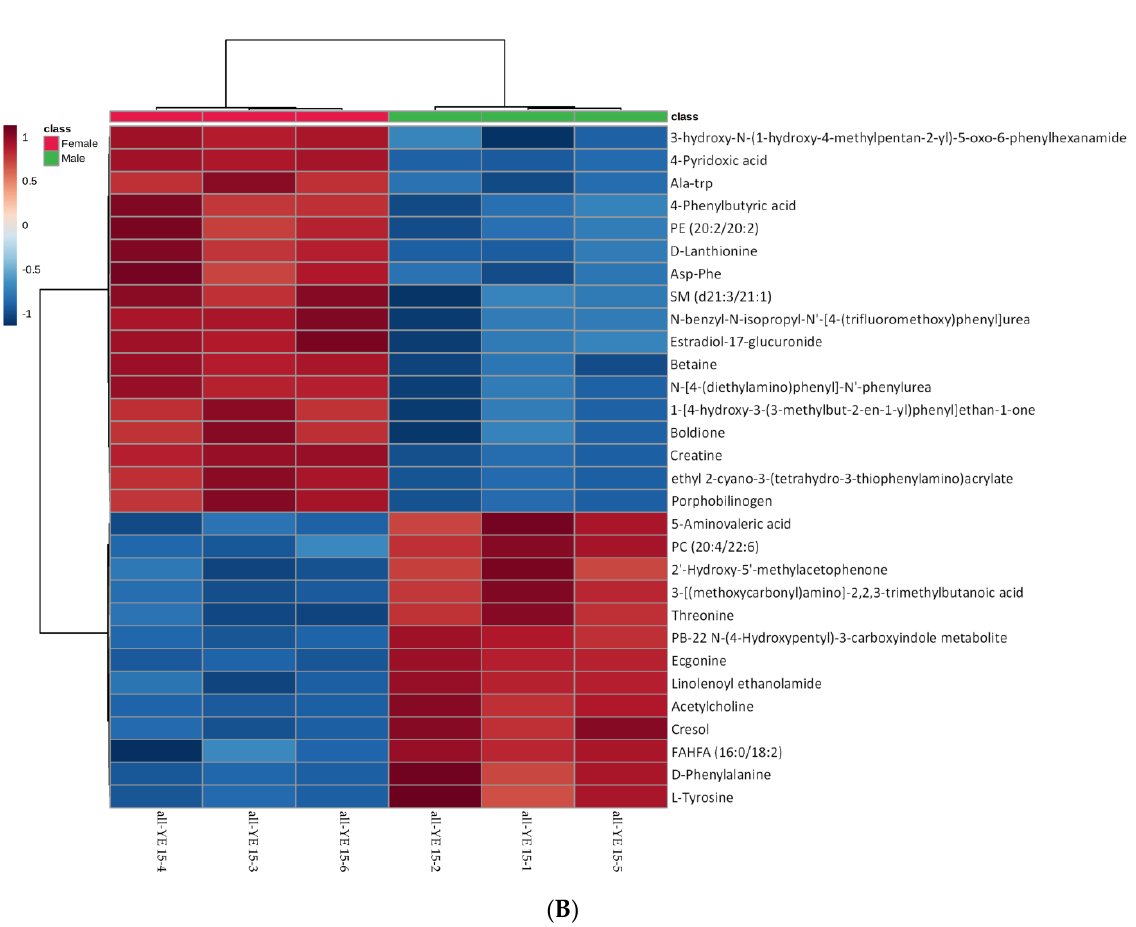
Table 5. Top 10 differential yolk metabolites identified between male and female chicken embryos at E19.